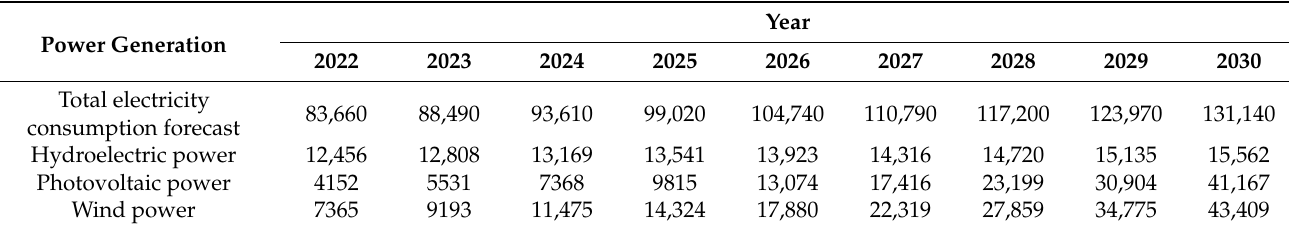
Table 4. China’s clean energy power generation forecast (Billion kWh).